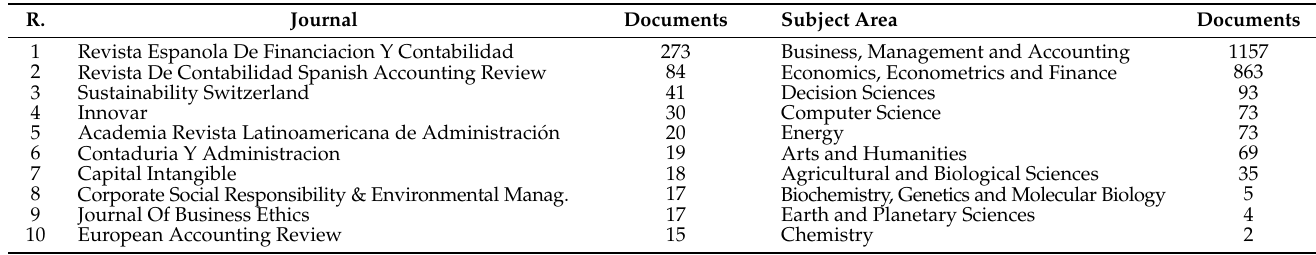
Table 4. Journals and Areas in which SJFA articles are most cited.